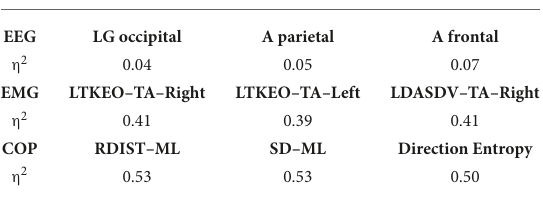
TABLE 3 Effect size